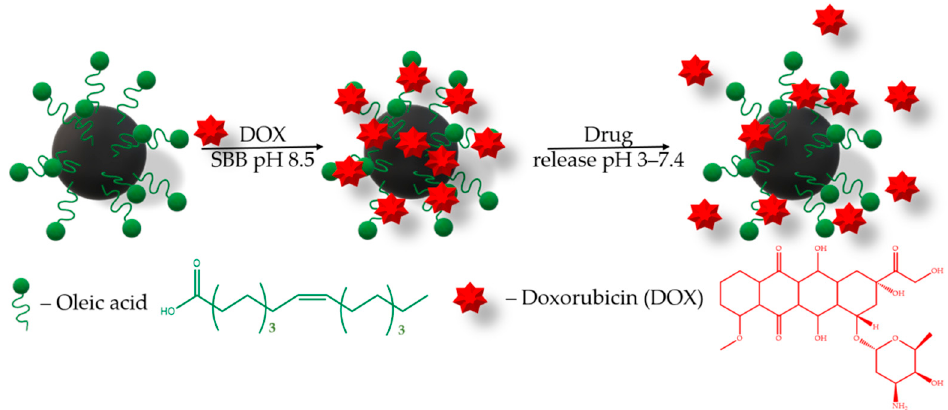
Figure 4. Schematic description of the DOX loading onto MNPs and release. Table 2. The comparison of the DOX loading MNP capacity.